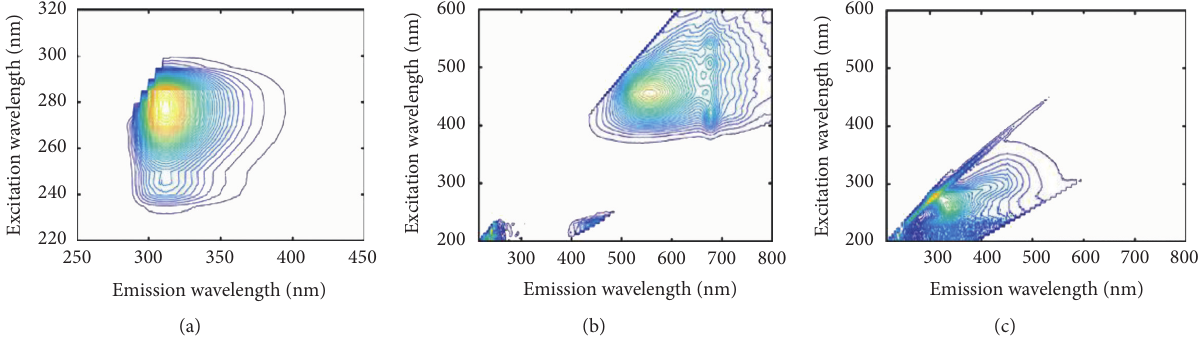
Figure 2: Three-dimensional fluorescence spectra of catechin monomer and different concentrations of tea solution. (a) Three-dimensional fluorescence spectrum of catechin monomer presents one characteristic excitation/emission ( λ ex � 280nm/ λ em � 310nm) maximum. (b) 0.02g/mL and (c) 0.2mg/mL of black tea clear liquid. Comparing (b) with (c), it was found that the fluorescence peak of catechin was obvious at low concentration.